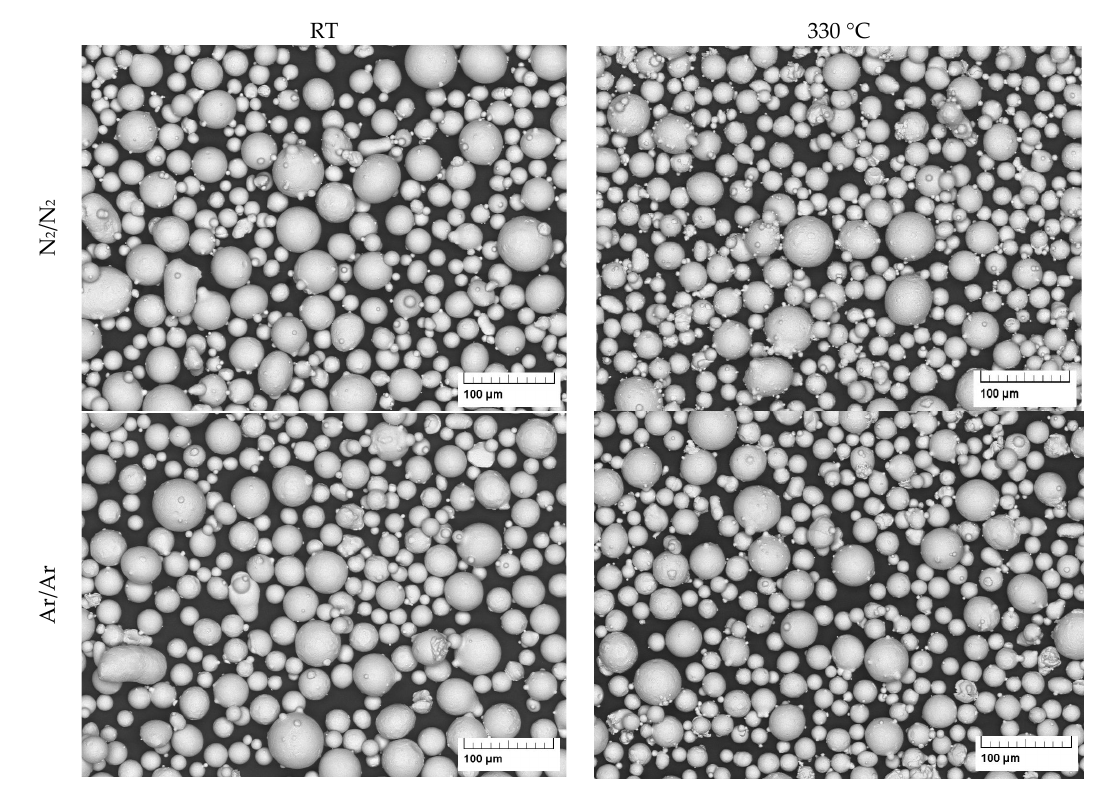
Figure 4. SEM images of gas atomized X2CrNiMoCuWN25-7-4 powders (particle size 20–63 µm, at low magnification).